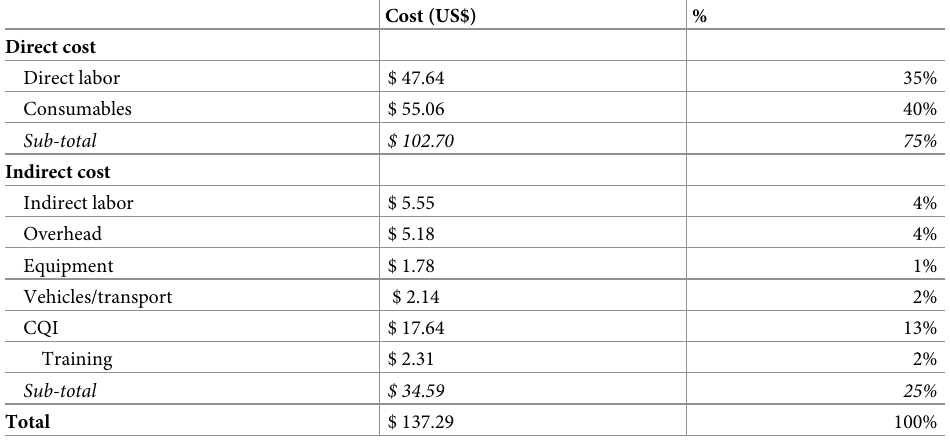
Table 2. VMMC unit